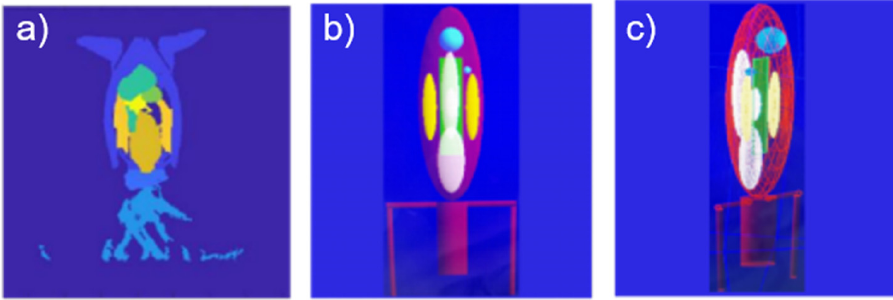
Figure 2. ( a ) A segmented MRI image of O. bartramii ; ( b ) the front image of the stylized model; ( c ) the